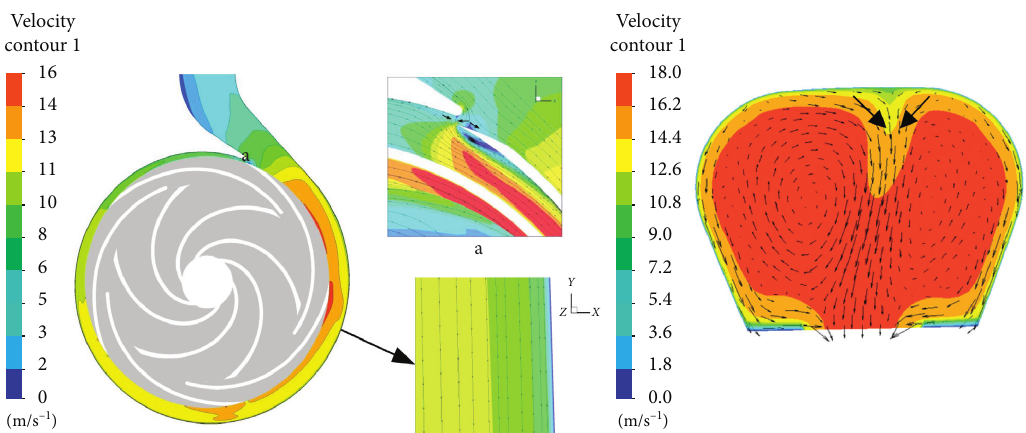
Figure 10: Streamlines in volute at ( Q ) � 48 m 3